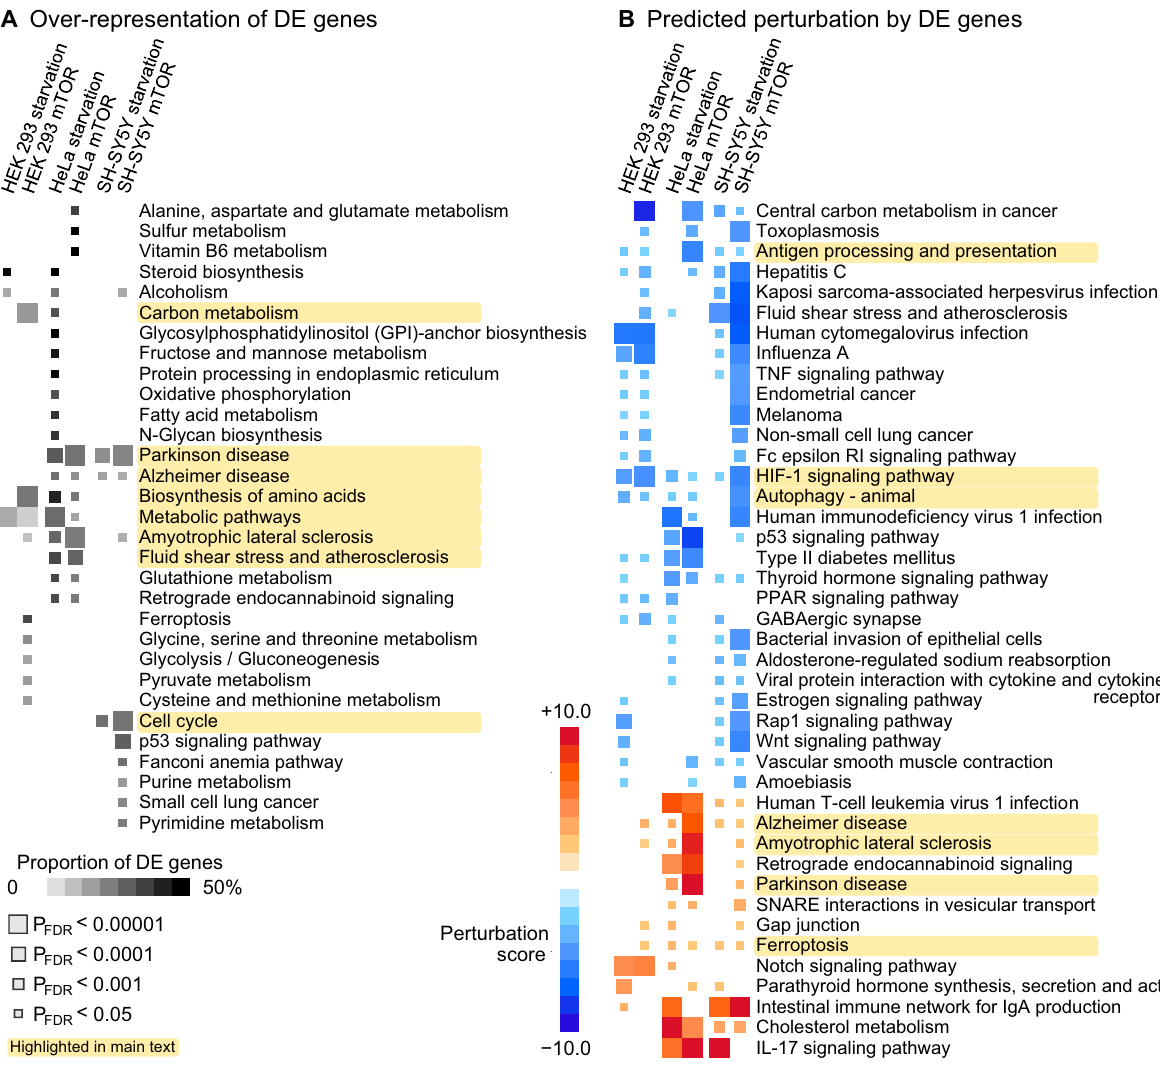
Figure 3. Enrichment of differentially expressed genes in the Kyoto Encyclopedia of Genes and Genomes pathway repository. ( A ) Over-representation analysis of DE genes. Pathways that produced a significant signal (P FDR < 0.05) in at least one experiment are shown. ( B ) Normalized perturbation scores from Signaling Pathway Impact Analysis. A negative (positive) score implies that the aggregate impact of DE genes is likely to decrease (increase) the activity of a pathway. Pathways that were directionally concordant (all significant signals in the same direction) and that produced at least three significant signals (P FDR < 0.05) are